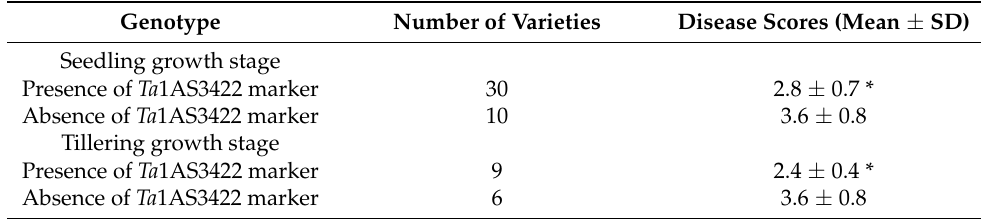
Table 1. Comparison of mean disease scores of hexaploid wheat varieties following infection with a ∆ toxa Ptr mutant at seedling and tillering growth stages